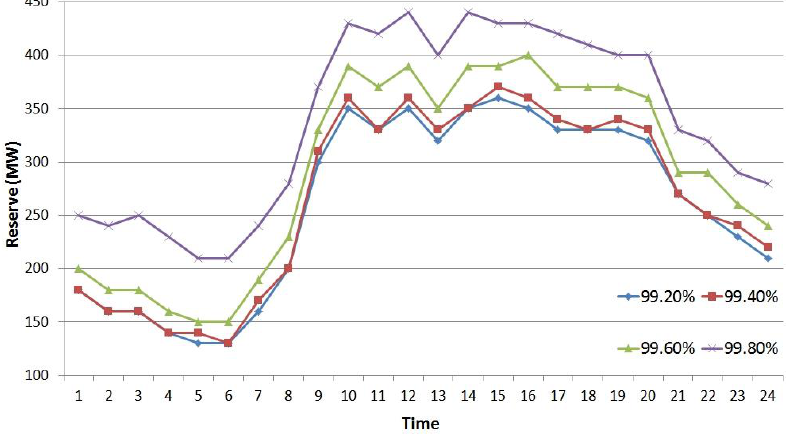
Figure 3. Hourly reserve margin with the short-term reliability of balance varied from 99.2% to 99.8%.